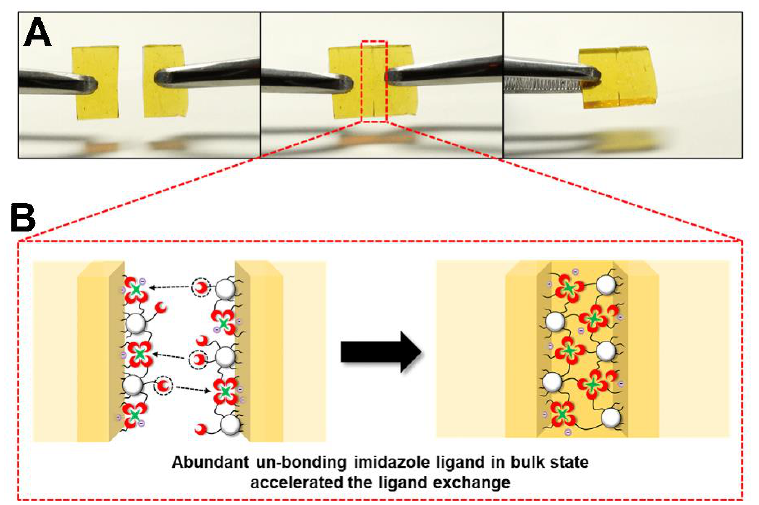
Figure 29. ( A ) Self-healing of POSS-B/Zn(OTf) 2 sample after 30 s of direct contact between frag- ments; ( B ) Illustration of self-healing mechanism accelerated by the presence of free imidazole groups. Reprinted from Mater. Today Chem. 2021, 22 , Sasaki, Y.; Yamamoto, T.; Mori, H., Mechanically robust, ion-conductive, self-healing glassy hybrid materials via tailored Zn/imidazole interaction, 100611, [92]. Copyright (2021), with permission from Elsevier.